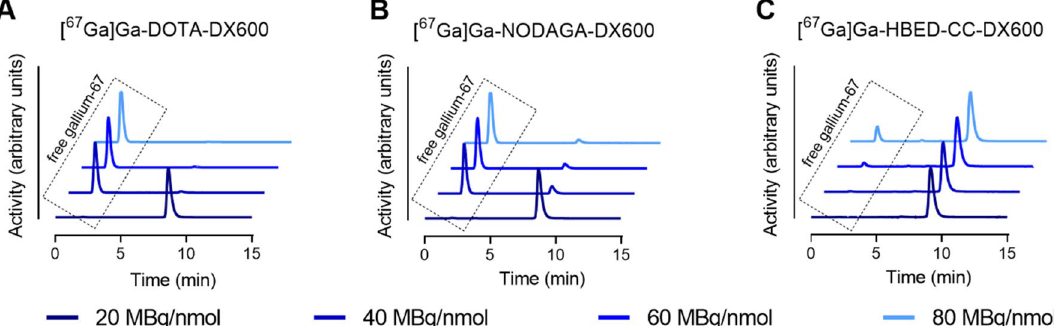
Fig. 4 Representative HPLC chromatograms of the radiopeptides prepared at variable molar activities (20–80 MBq/nmol). A [ 67